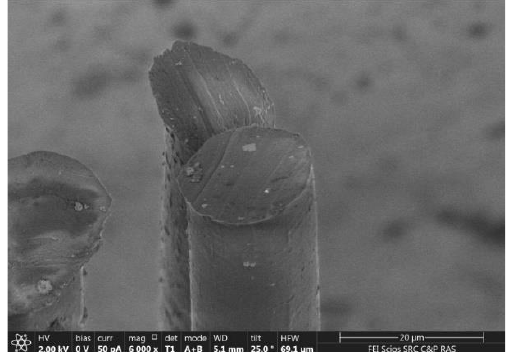
Figure 12. Micrographs of fibers spun from flax noils cellulose.